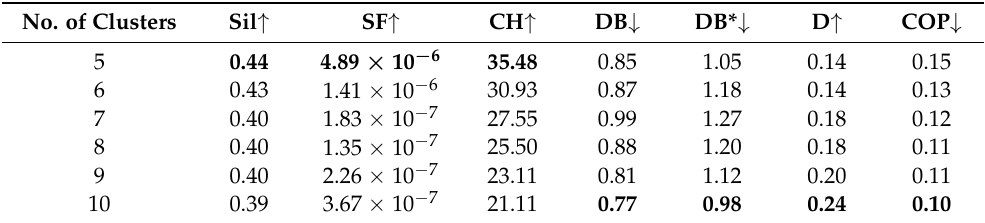
Table 1. CVIs results for the multivariate time series analysis on PCE and TCE data: Silhuette (Sil), to be maximized; Dunn index (D), to be maximized; COP index (COP), to be minimized; Davies-Bouldin index (DB), to be minimized; Modified Davies-Bouldin index (DB*), to be minimized; Calinski- Harabasz index (CH), to be maximized; Score Function (SF), to be minimized. Bold font indicates the best solution according to each